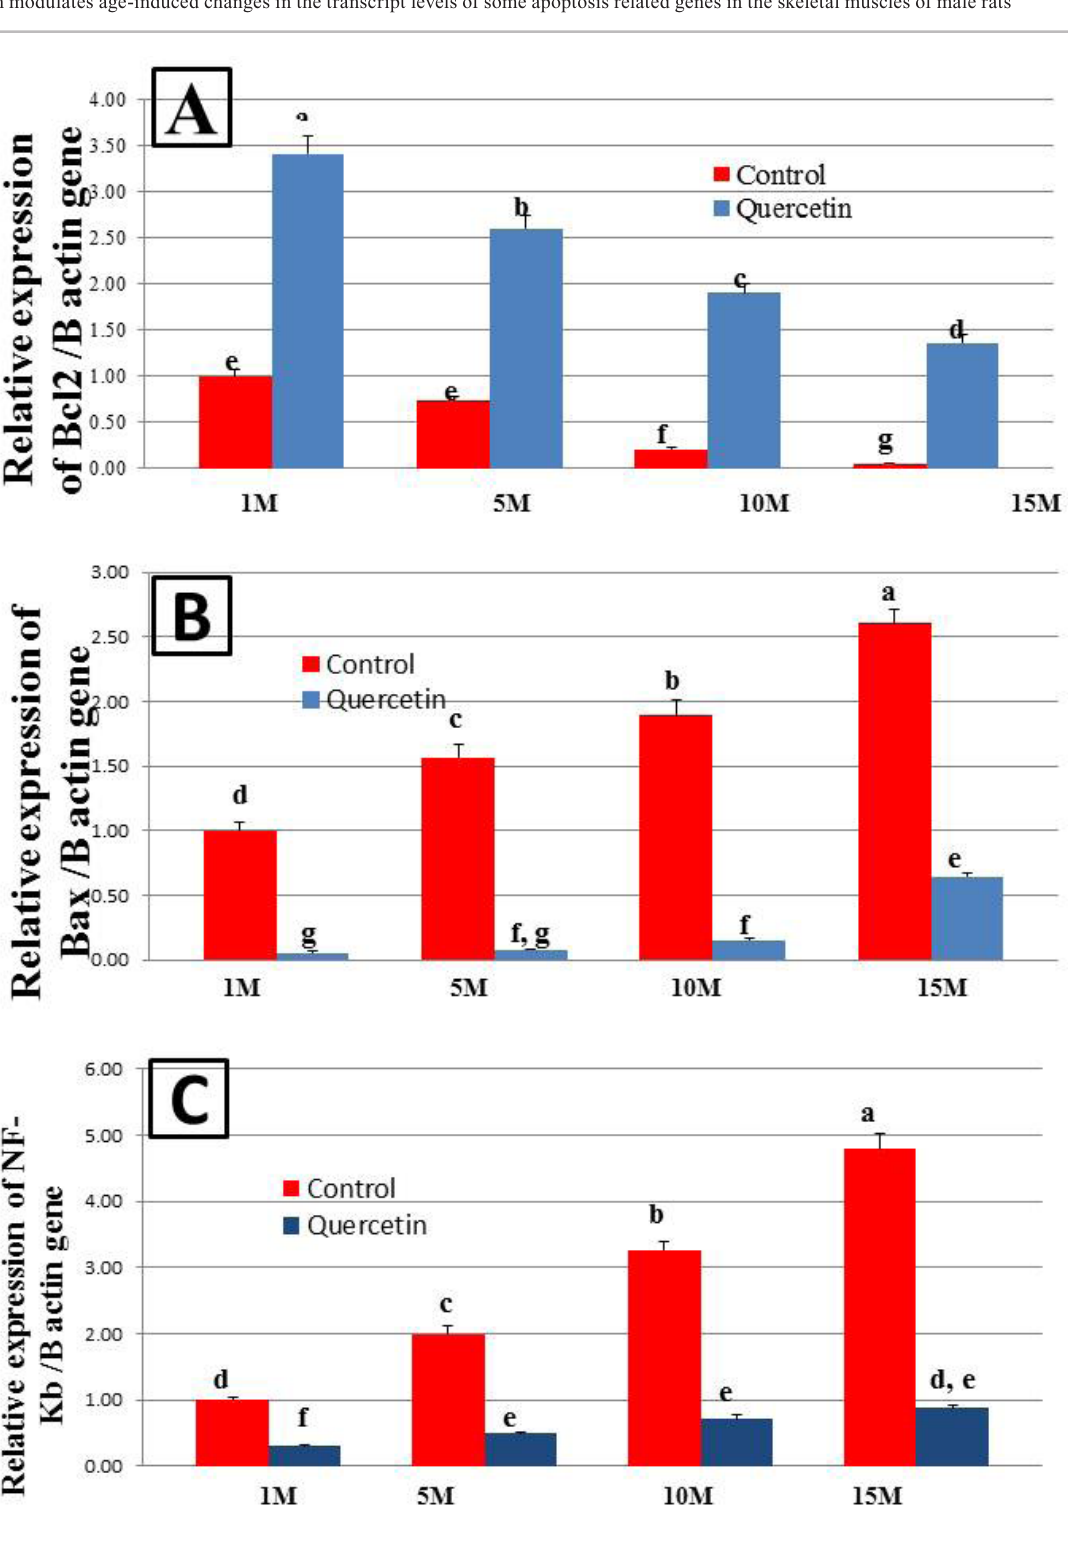
FIGURE 2 - Graphical presentation of a real-time quantitative PCR analysis of Bcl2, Bax and NF- κ B genes in the gastrocnemius muscles of the rats that had 1, 5, 10 and 15 month old (1 M, 5 M, 10 M and 15 M), respectively. Control and quercetin: Rats that were taken a vehicle and quercetin, respectively Data are means ± SE with n=3, Different letters indicate significant differences among the columns (p ≤